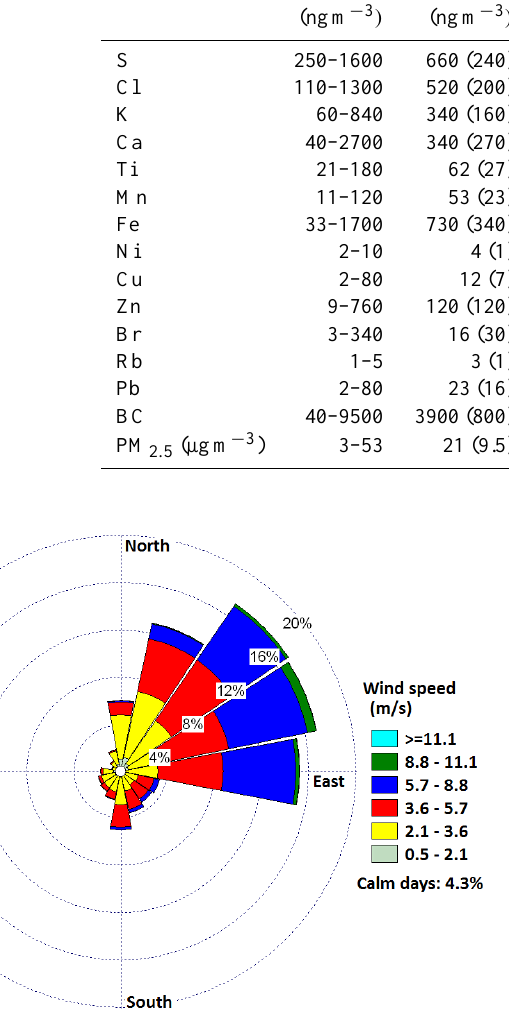
Figure 2. Wind speed and direction during the sampling period, i.e., from 22 May 2008 to 30 March 2010. The wind data were measured at Jomo Kenyatta International Airport (JKIA), Nairobi, which is approximately 12km southeast of the city center.